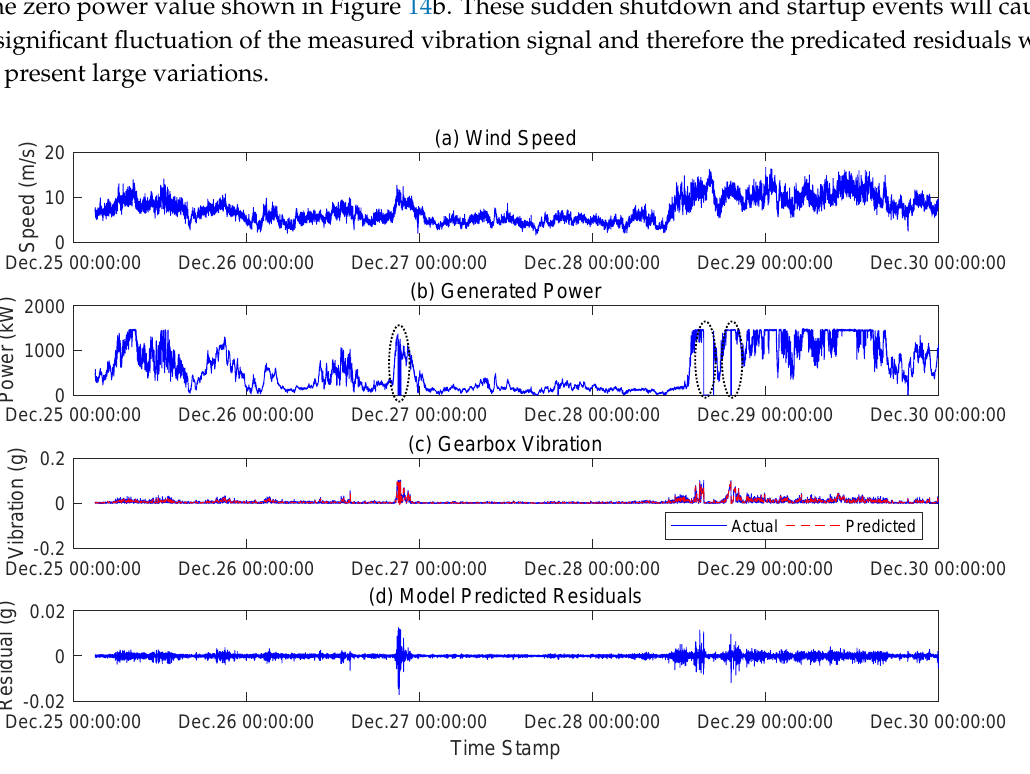
Figure 14. Residuals of the validation set and its corresponding wind speed, active power and gearbox